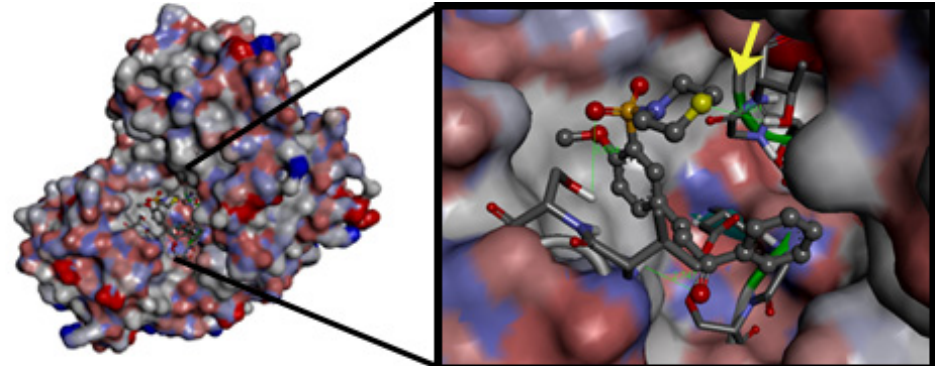
Figure 4. Compound 1a docked into the plasmepsin-2 (PL-2) binding site, generated by AutoDock Vina and viewed by Discovery Studio Client (version 3.1.1.11157).